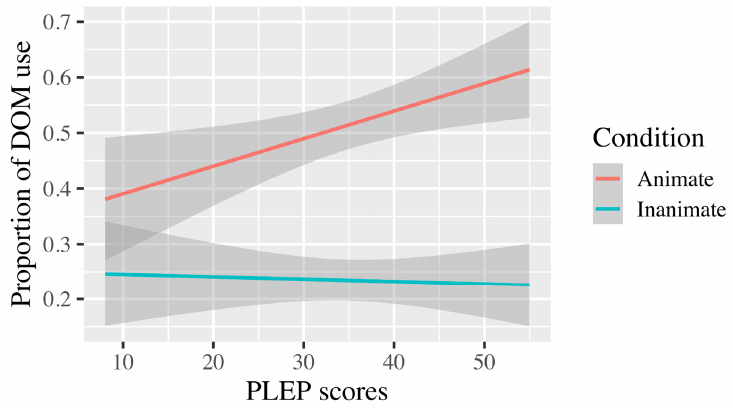
Figure 1. Proportion of DOM use according to PLEP scores in the Spanish EPT.